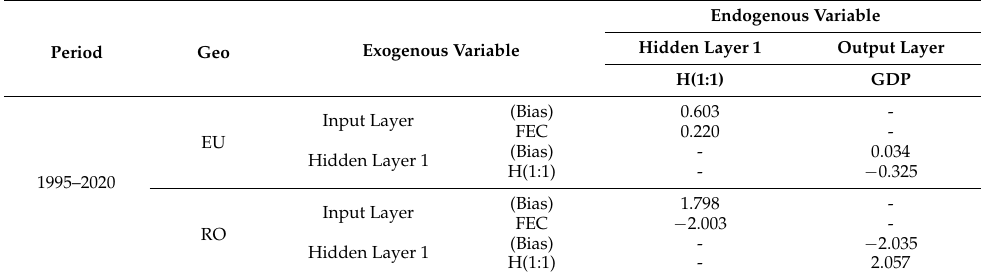
Table A4. Estimation of MLP network parameters on FEC and